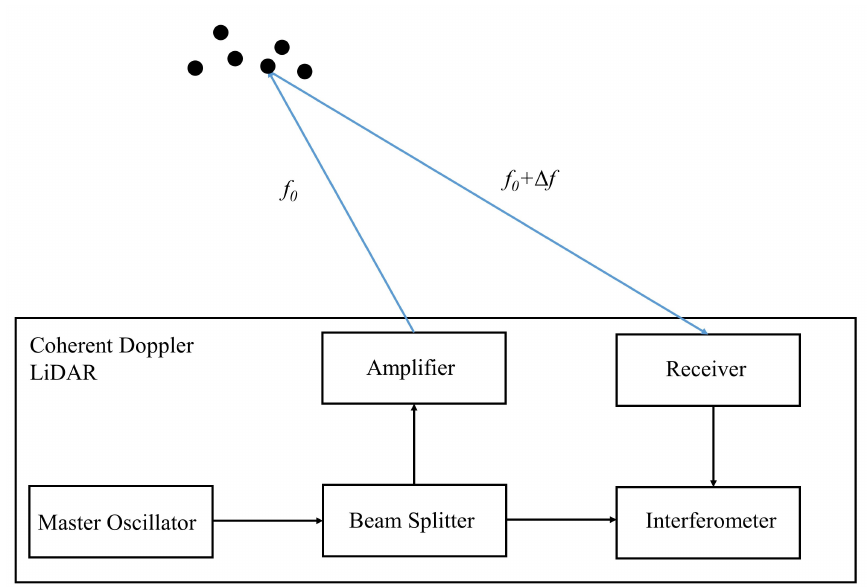
Figure 1. Schematic diagram of the coherent Light Detection And Ranging (LiDAR) system.